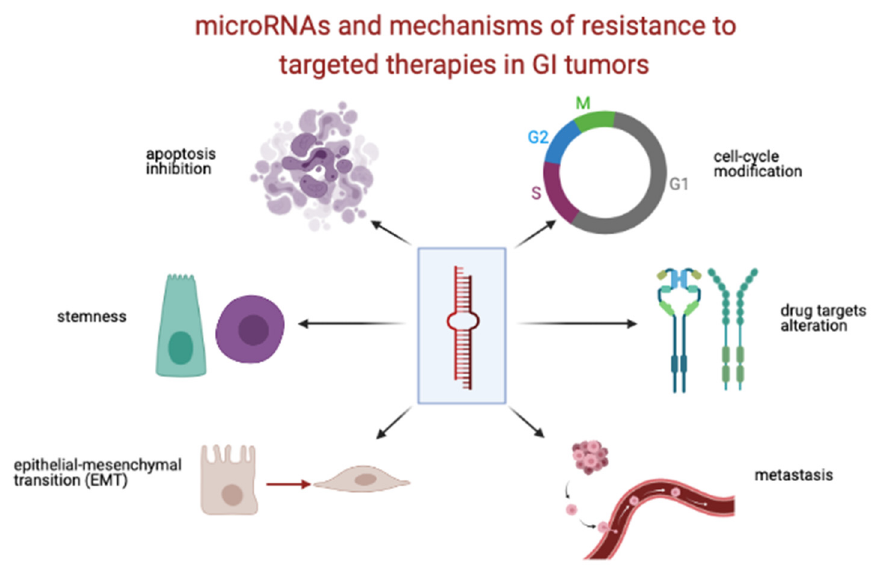
Figure 1. MiRNAs and mechanisms of resistance to targeted therapies in GI tumors. Credits to BioRender.com, accessed date 18 March